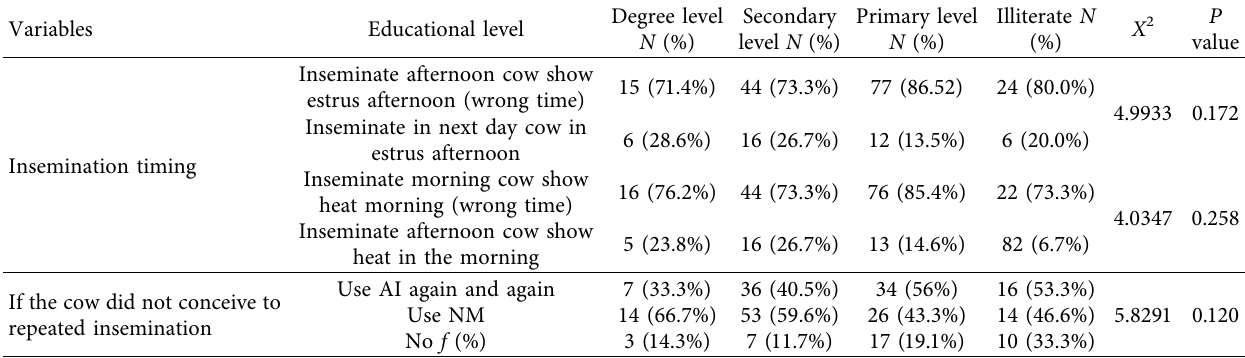
Table 2: Association of AI services with the level of owner’s education.